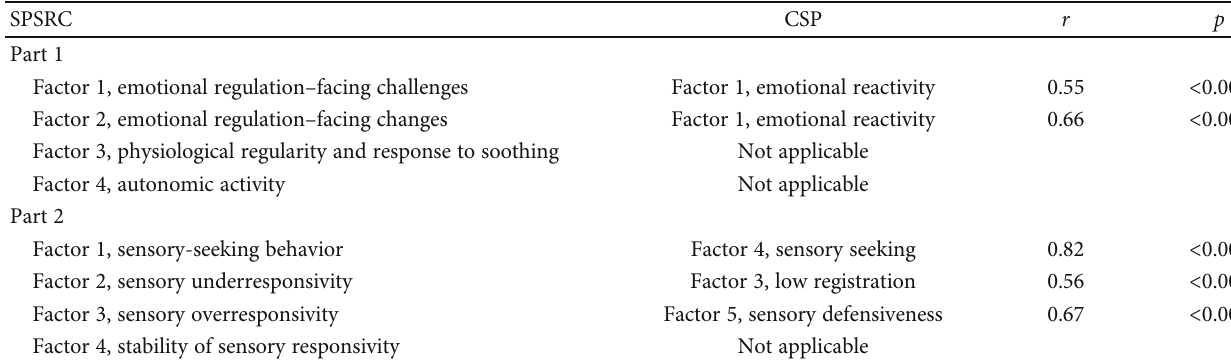
Table 2: Correlation between the latent factors of SPSRC and